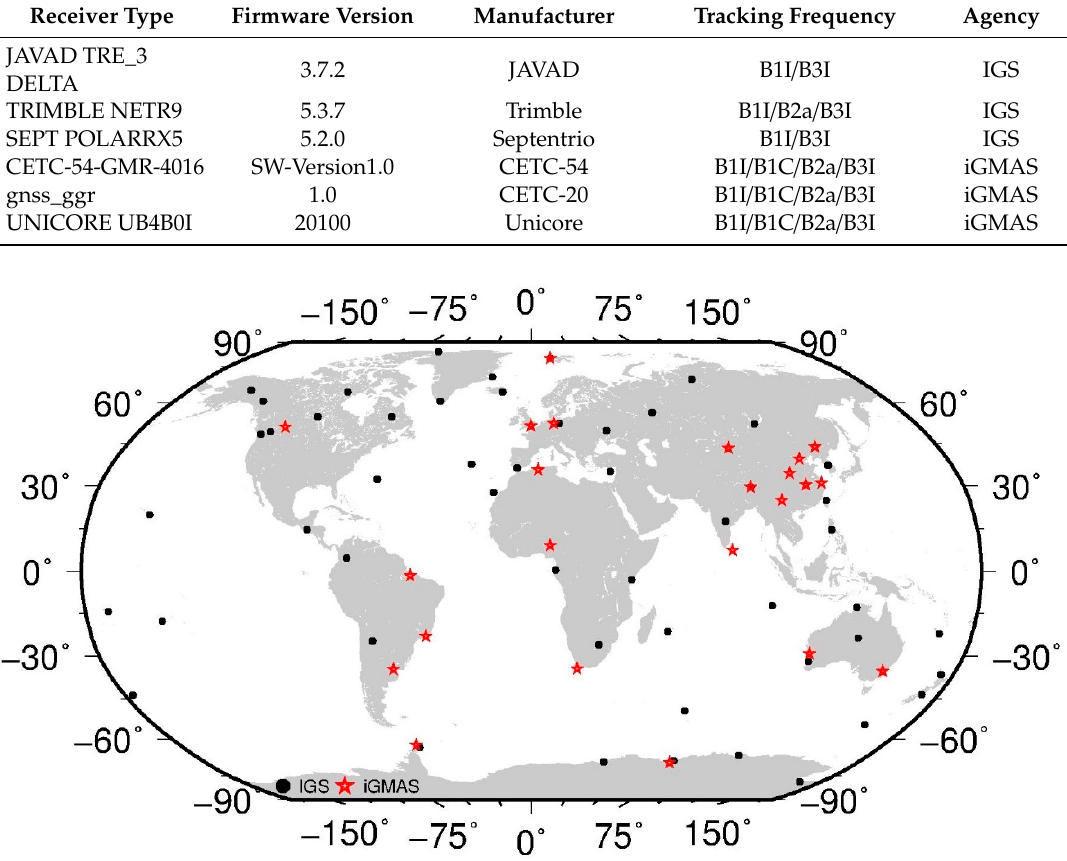
Figure 1. The distribution of stations from the International GNSS Service (IGS) and international GNSS Monitoring and Assessment Service (iGMAS) backbone network which can track the BD3 open service signals. The block dots represent the IGS stations and the red stars represent the iGMAS stations.